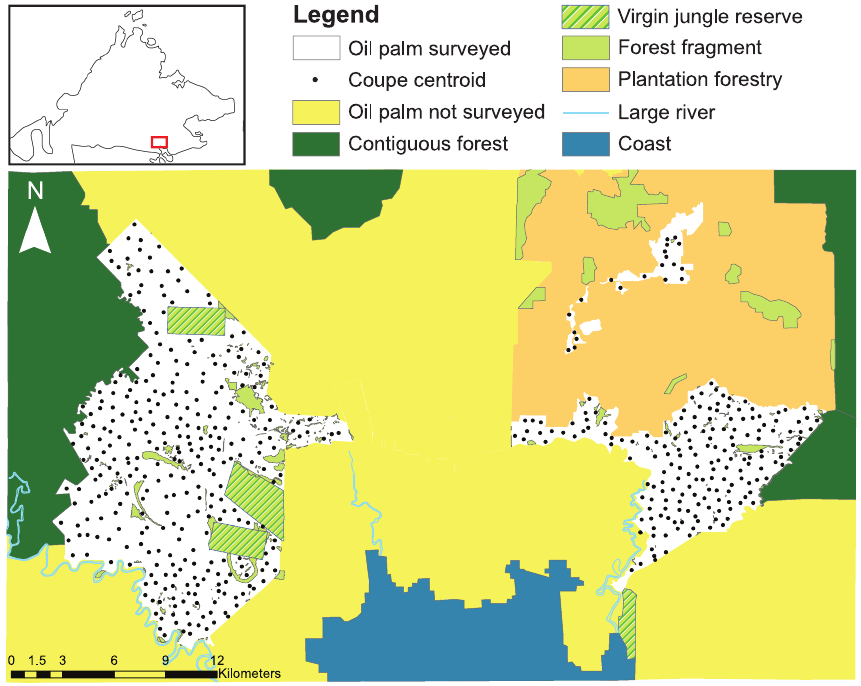
Figure 1. Different land-use types within the study area. The inset shows Sabah, Northeast Borneo, and the red box denotes the study area.